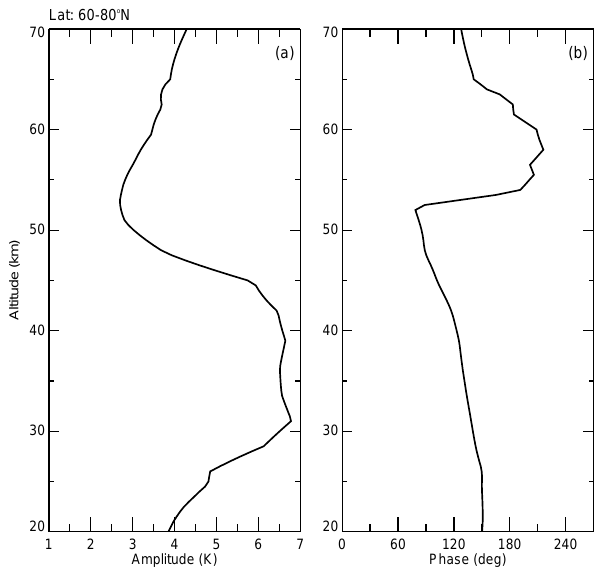
Fig. 6. Profiles of (a) amplitude and (b) phase of 20–30 day waves observed over 60–80 ◦ N latitude range during November 2008 to March